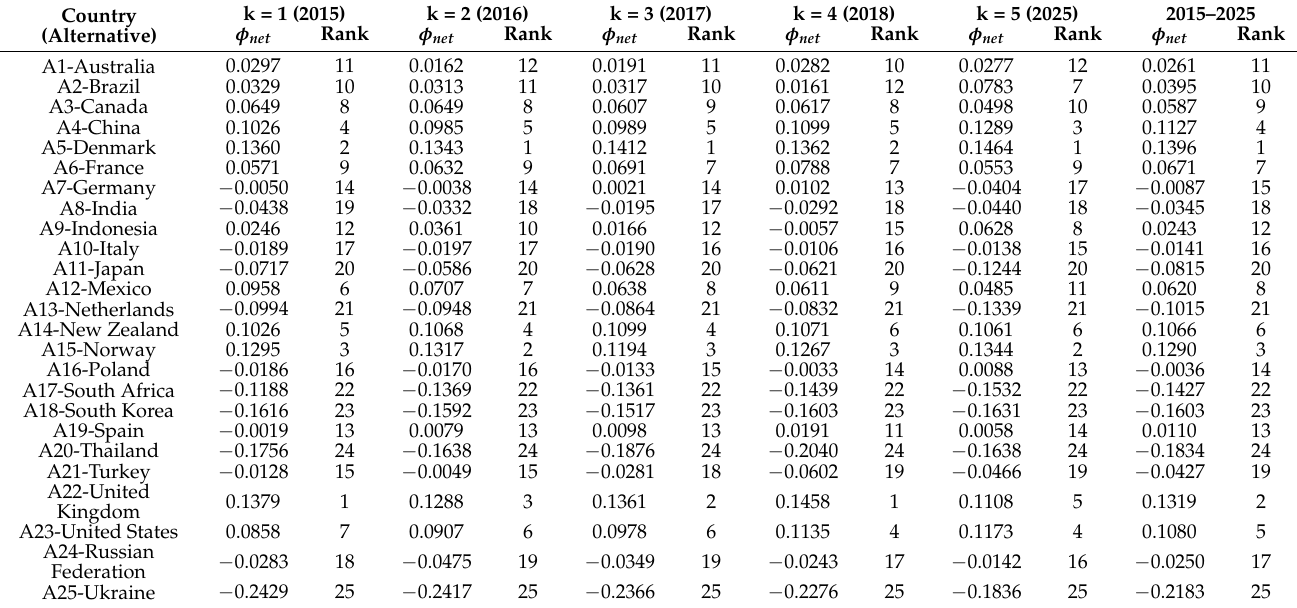
Table 5. The results of energy security assessment with the use of a coherent family of criteria and the NEAT F-PROMETHEE II